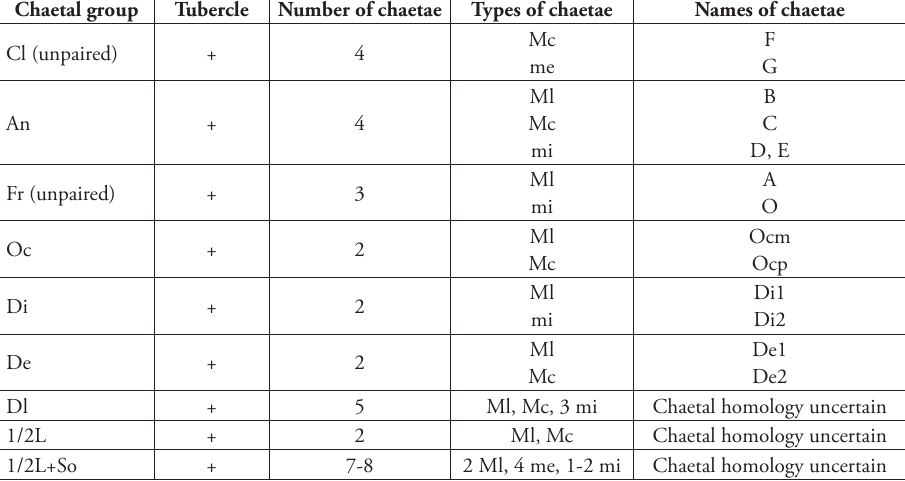
Table 1a. Chaetotaxy of Lobellina weinerae sp. n.: cephalic chaetotaxy of dorsal side. Chaetal group Tubercle